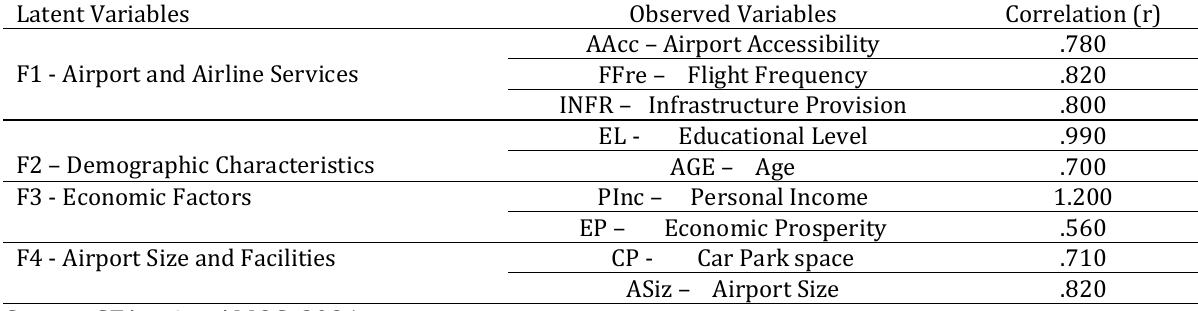
Table 11: Model Construct of factors influencing domestic air traffic